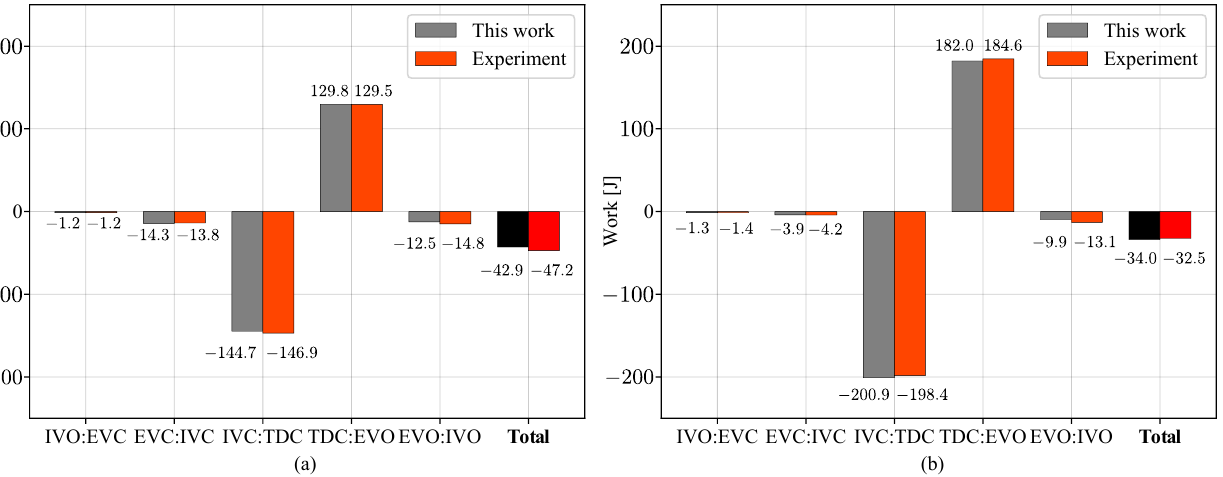
Figure 13. Net work separated for each engine phase and total work: ( a ) throttle at 35 ◦ ; ( b ) throttle at 80 ◦ . Table 5. Estimated volumetric efficiencies for the two throttle cases. η Case Exp.